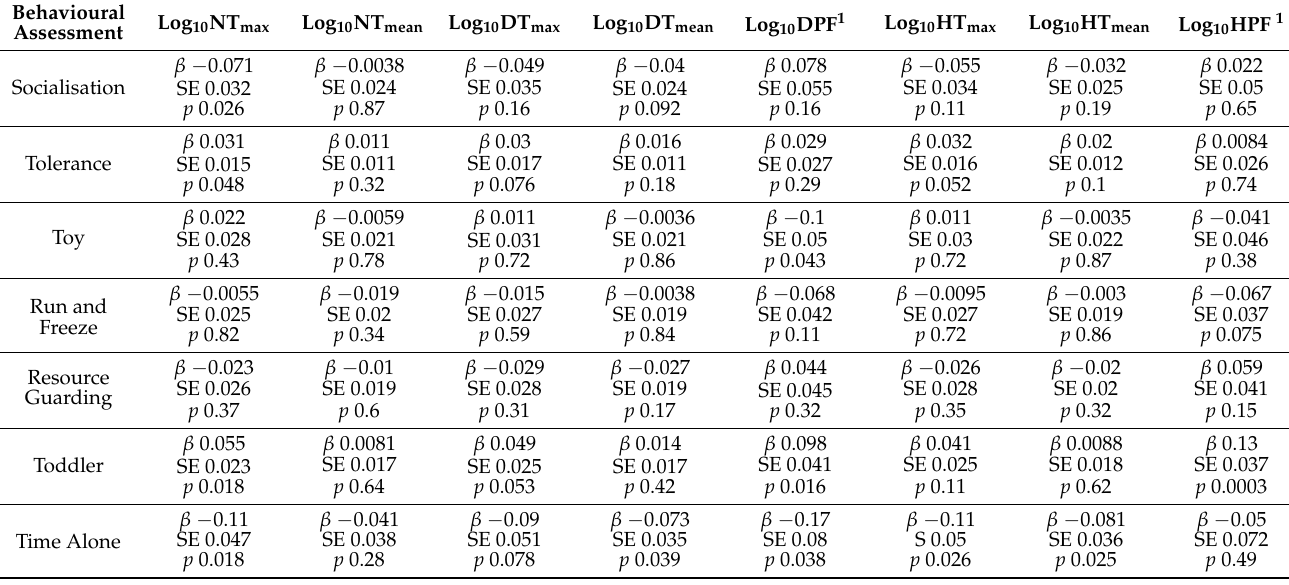
Table 5. Generalised linear mixed model of the effect of canine behavioural assessment on leash tension and pulling